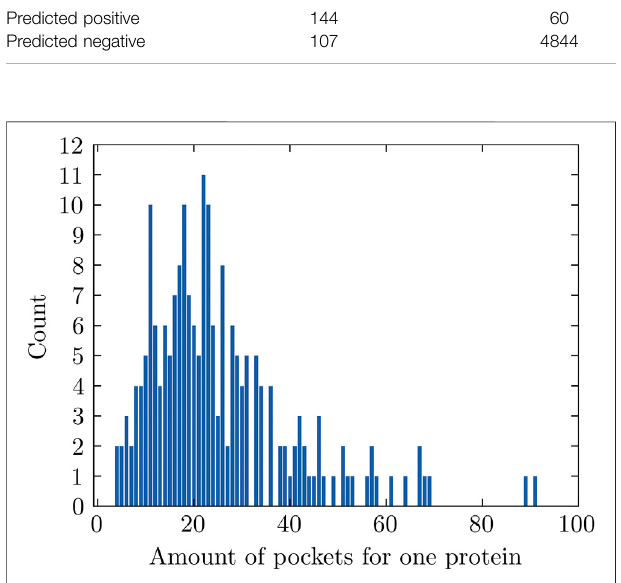
FIGURE 2 | Amounts of pockets for proteins. The amount varies from 4 to